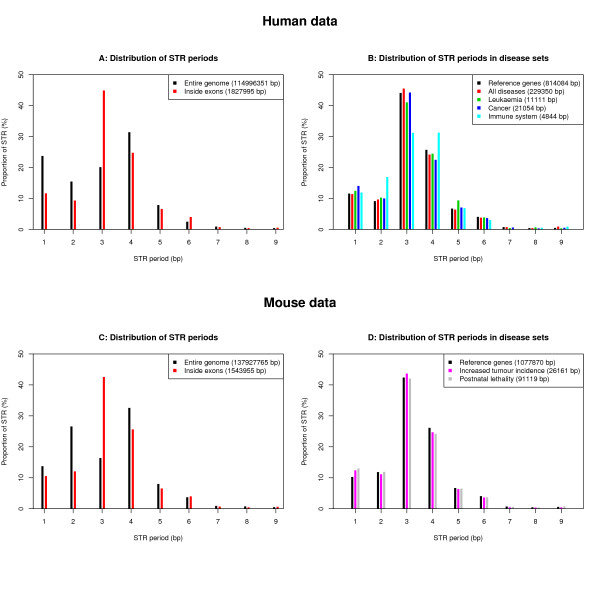
Distribution of STR periods. The proportion of STR of each period in the human (A) and mouse (C) genome; a segment of STR is always assigned to the lowest possible period. The proportion of STR of each period, for each of the disease sets in human (B) and mouse (D).